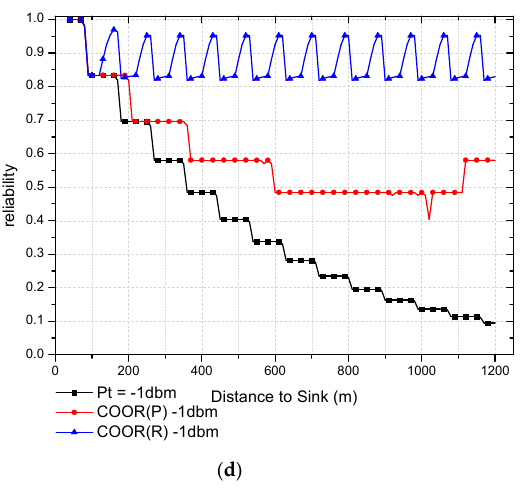
Figure 17. ( a ) End-to-end reliability of node at different distance under r = 60, N = 2; ( b ) End-to-end reliability of node at different distance under r = 70, N = 3; ( c ) End-to-end reliability of node at different distance under r = 80, N = 4; ( d ) End-to-end reliability of node at different distance under r = 90, N = 4.